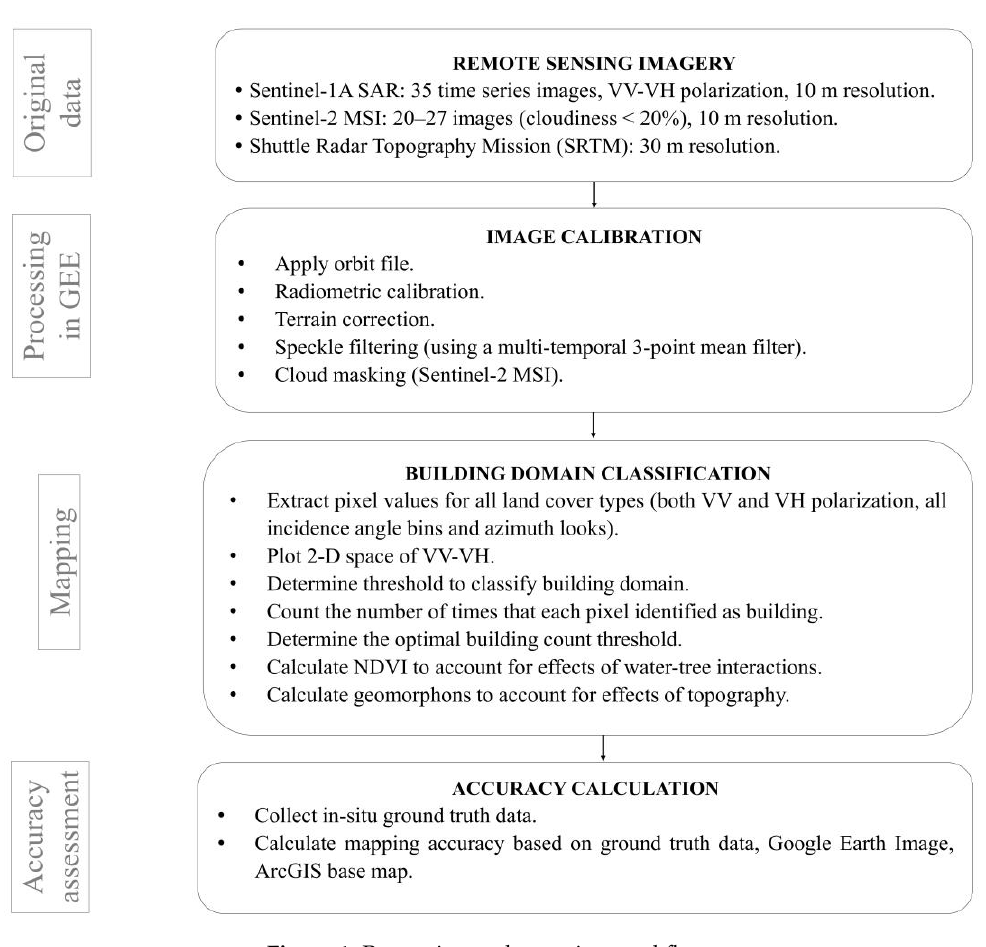
Figure 1. Processing and mapping workflow.